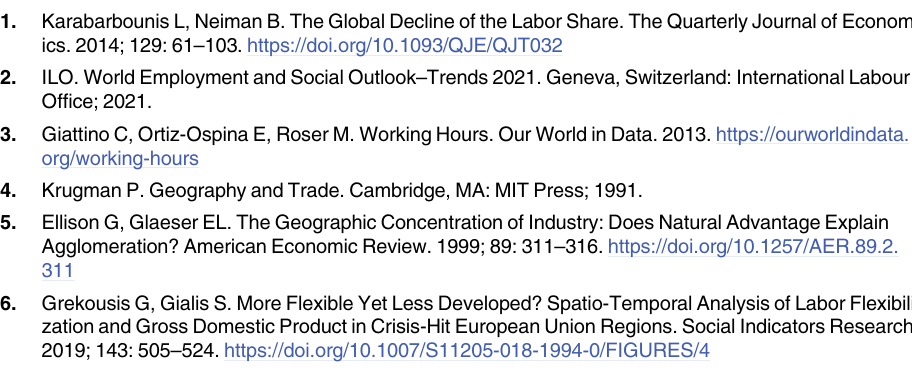
S2 File. Variable importance plots. Results are presented for the five super learner model members with the highest weight and for the top 10 predictors. Starting values for the horizon- tal bars indicate the RMSE for the full model. Predictors with the largest bars are the most important because permuting them results in higher RMSE. Error bars indicate results for 10 different permutations. S3 File. Accumulated local effects. Results are presented for the five super learner model members with the highest